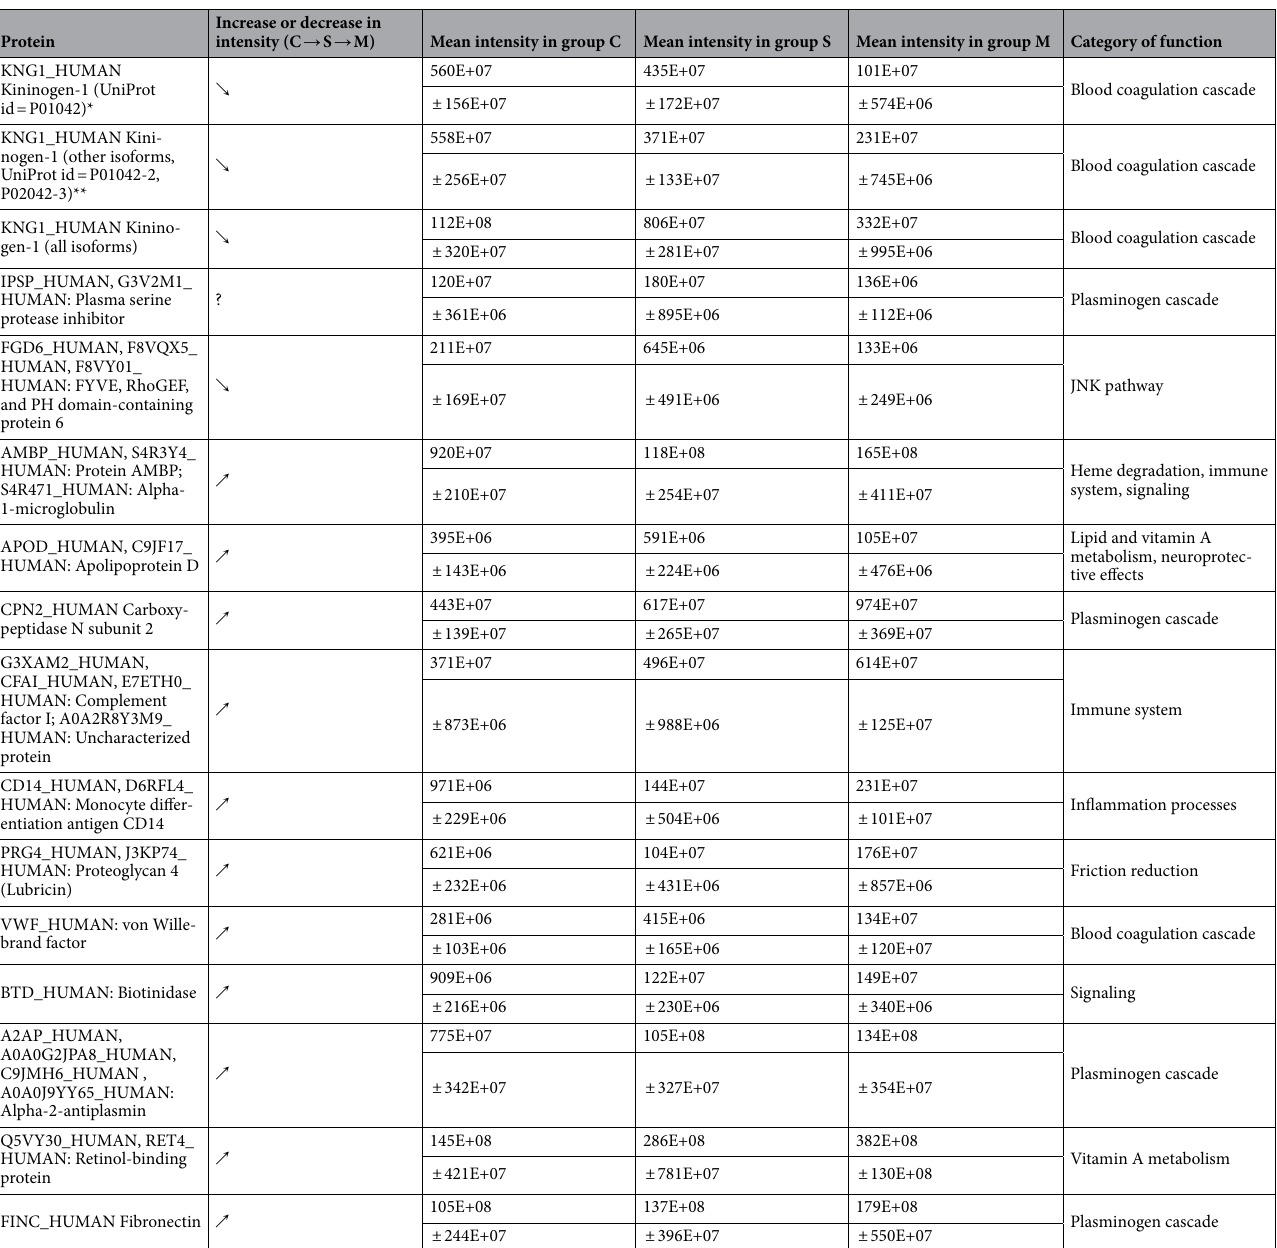
Table 4. Proteins with a significant change in intensity regardless of groups selected for comparison. Proteins with a significant change in protein intensity quantification values when comparing any two groups of C, S, and M, i.e., the set (M versus S) ∩ (M versus C) ∩ (S versus C) of 15 proteins. Protein intensity quantification values are given together with one standard deviation. *MaxQuant search id 181, **MaxQuant search id